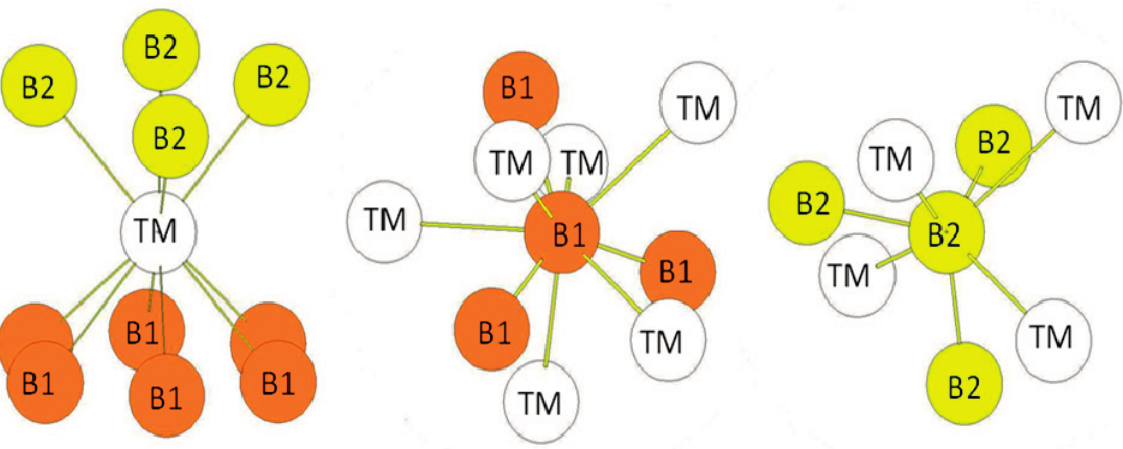
Figure 6. Environment of TM and B atoms in the hR6 (MoB 2 -type) structure. The Wyckoff positions of B1 and B2 atoms in the R(-)3m group space are 2c (x = y = z = 0.33219) and 2c (x = y = z = 0.18146) (see Table 1).